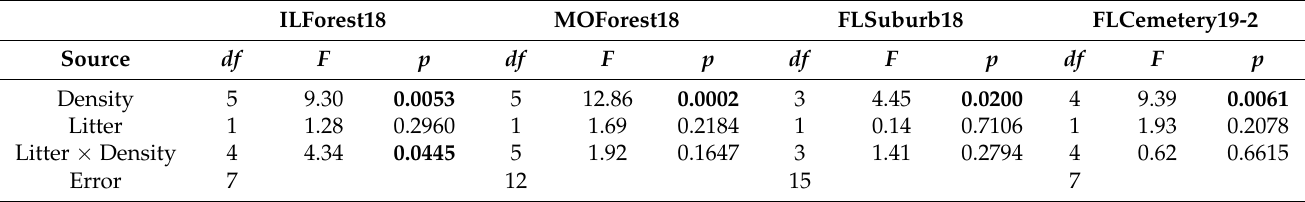
Table A1. Two-way fixed effects ANOVAs on number of survivors, testing for effects of adding litter, initial larval density, and interaction for the four experiments where collected litter was added to one half of the containers. Significant effects indicated in